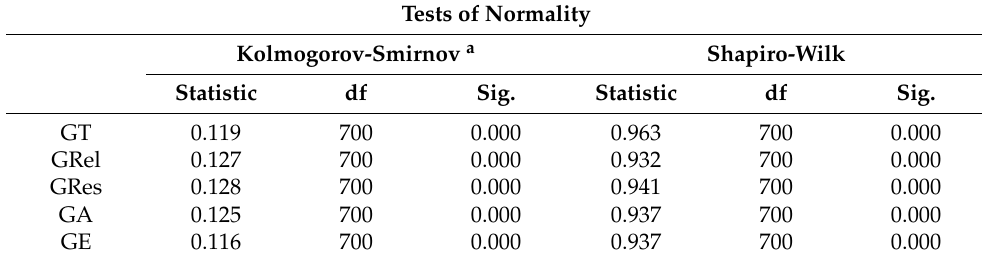
Table 1. Normality tests for SERVQUAL